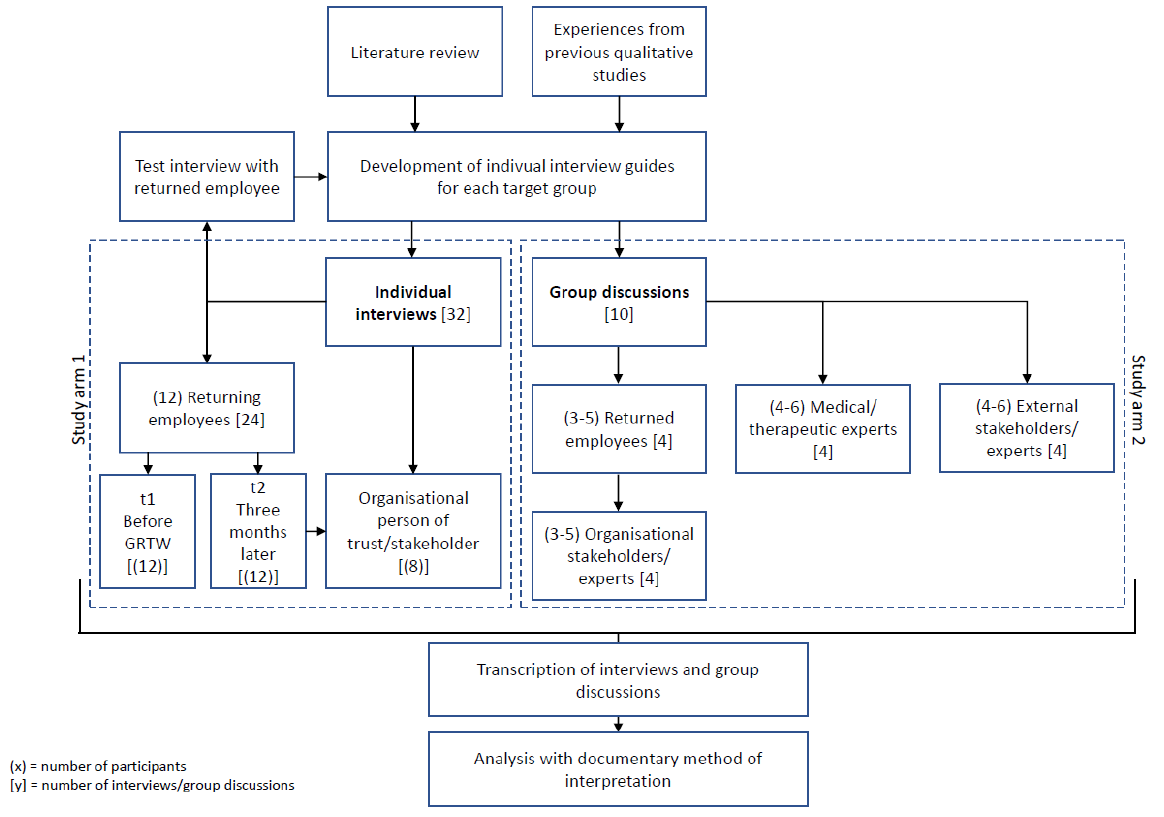
Figure 1. Planned data collection and its